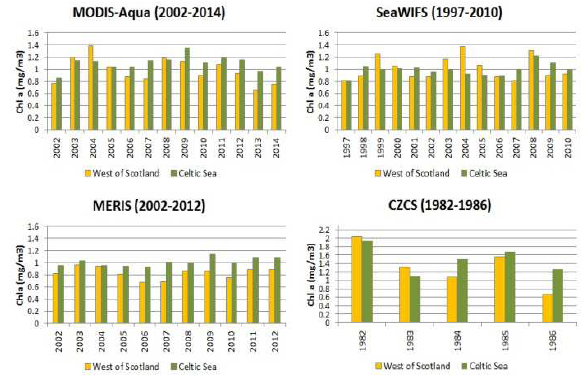
Figure 6. Chl-a concentrations for the West of Scotland and Celtic Sea. To avoid the variations in calibration strategies and Figure 7. Chlorophyll-a concentration for the different ICES algorithms the data are presented and analysed individually for Divisions. Data presented are extracted from MODIS-Aqua, each sensor. SeaWIFs and MERIS that present a temporal continuity with regard to each